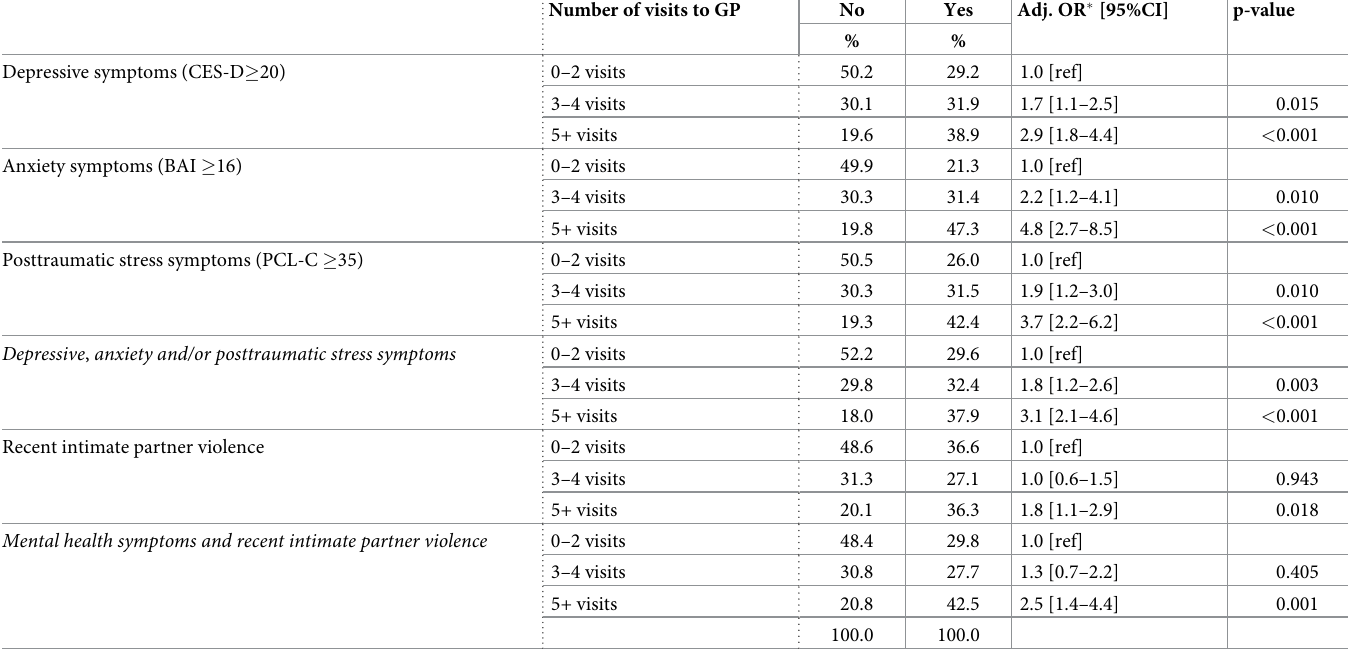
Table 3. Patterns in the number of visits to general practitioners in the 12 months prior to 10-year follow-up for women experiencing mental health symptoms and recent IPV (n = 1507). Number of visits to